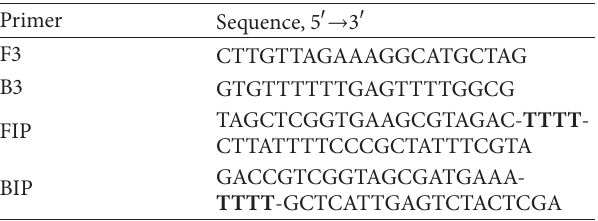
Table1:Setofprimersusedforamplificationof Ascarislumbricoides worm (positive control) and